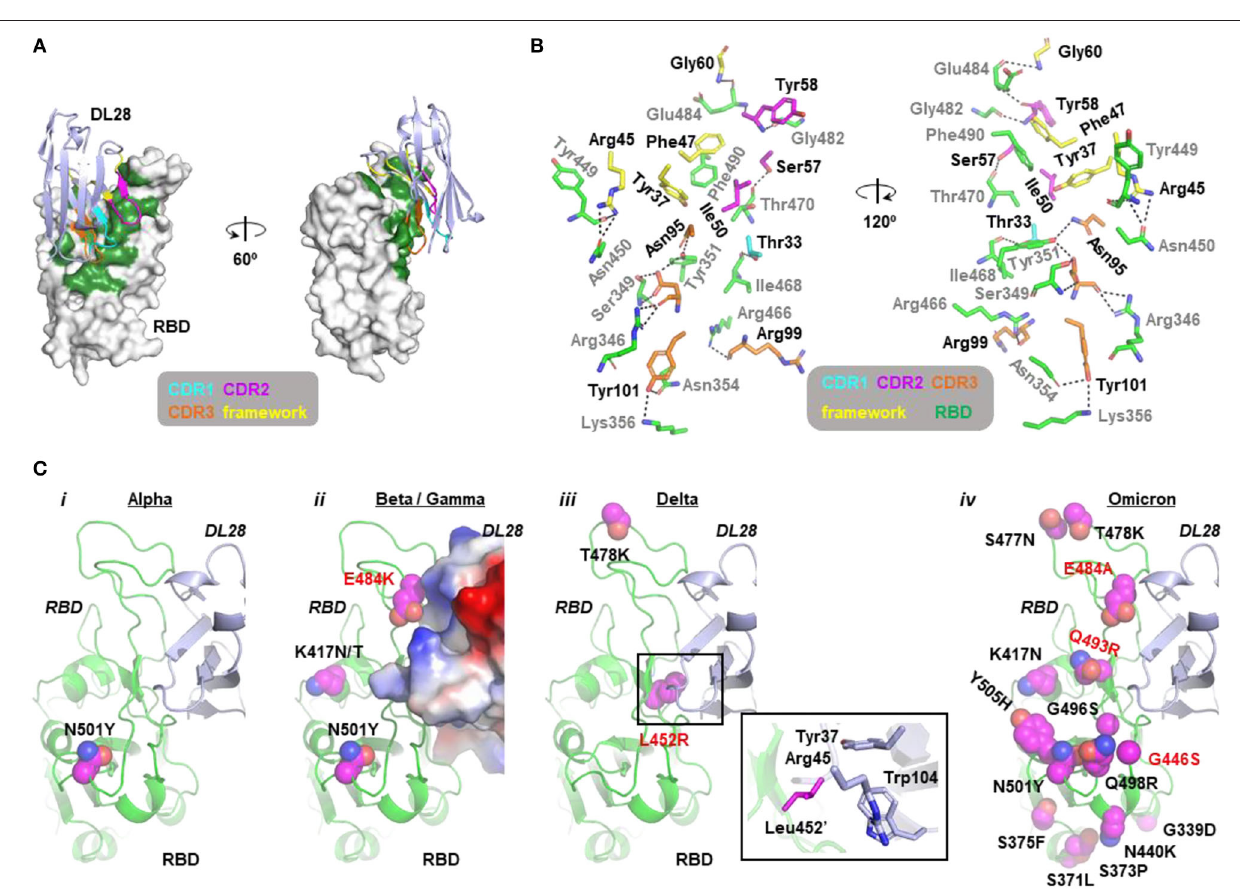
FIGURE 3 | Molecular insights into the activity of DL28 against SARS-CoV-2 variants. (A) The overall structure of DL28 (light blue) in complex with RBD (white). DL28 binds the high-chair-shaped RBD at one side. The binding interface is colored green. Three complementarity-determining regions (CDRs) and the framework residues involved in the binding are color-coded as indicated. (B) Stick representation of the interaction residues from DL28 (cyan, magenta, orange, and yellow) and RBD (green). DL28 residues are labeled in black and RBD residues are labeled in gray. Dash lines indicate distances within 3.8 Å. (C) The distribution of RBD mutations (magenta sphere) from the Alpha (i) , Beta/Gamma (ii) , Delta (iii) , and Omicron (iv) variants in the context of the DL28 epitope. RBD (green) and DL28 (blue) are shown as ribbon representations except that DL28 is shown as Adaptive Poisson-Boltzmann Solver electrostatic potential surfaces in ii . The expanded view in iii highlights the interaction between Leu452’ and indicated DL28